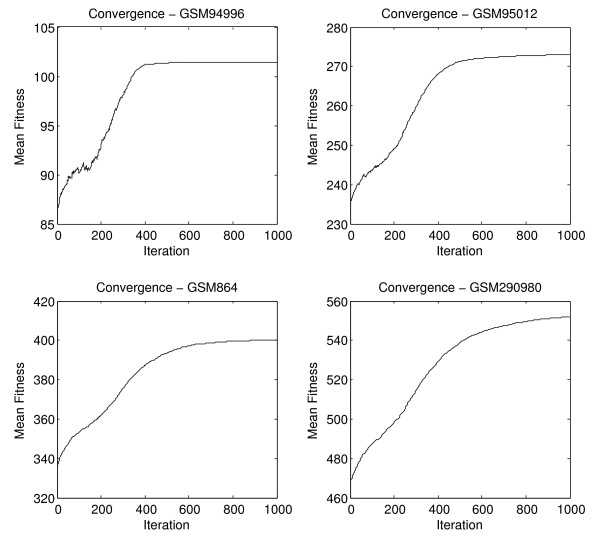
Convergence of module algorithm. Experiments were chosen to cover the range of fitness values reached in all microarray experiments for GPL17.